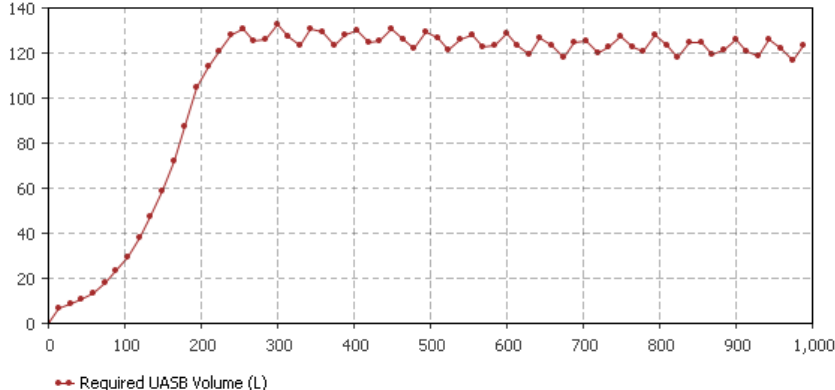
Figure 18. The required volume (L) of the UASB is dependent on the inflowing sludge, its SRT, and the HRT. Here, we assume that the sludge blanket covers 60% of the UASB reactor’s volume. Thus, the total filling capacity is around 140 L and serves as a good indication for sizing the reactor. The days are displayed on the x ‐ axis.